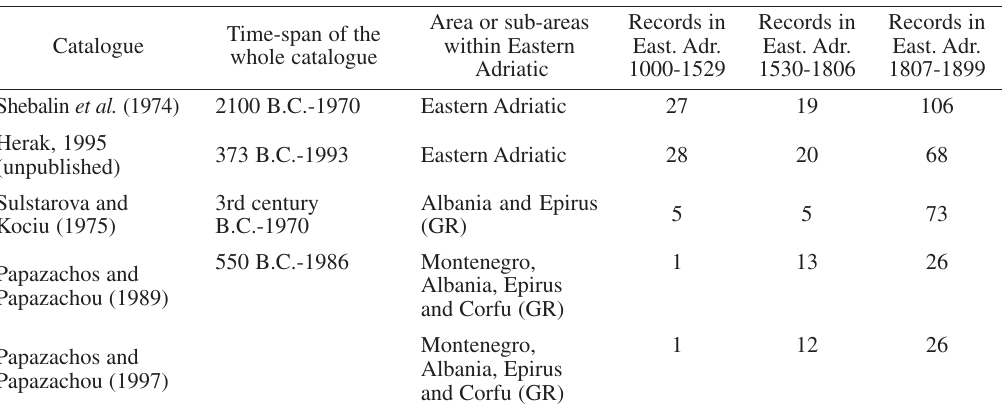
Table I. Time and space coverage of the main catalogues for Eastern